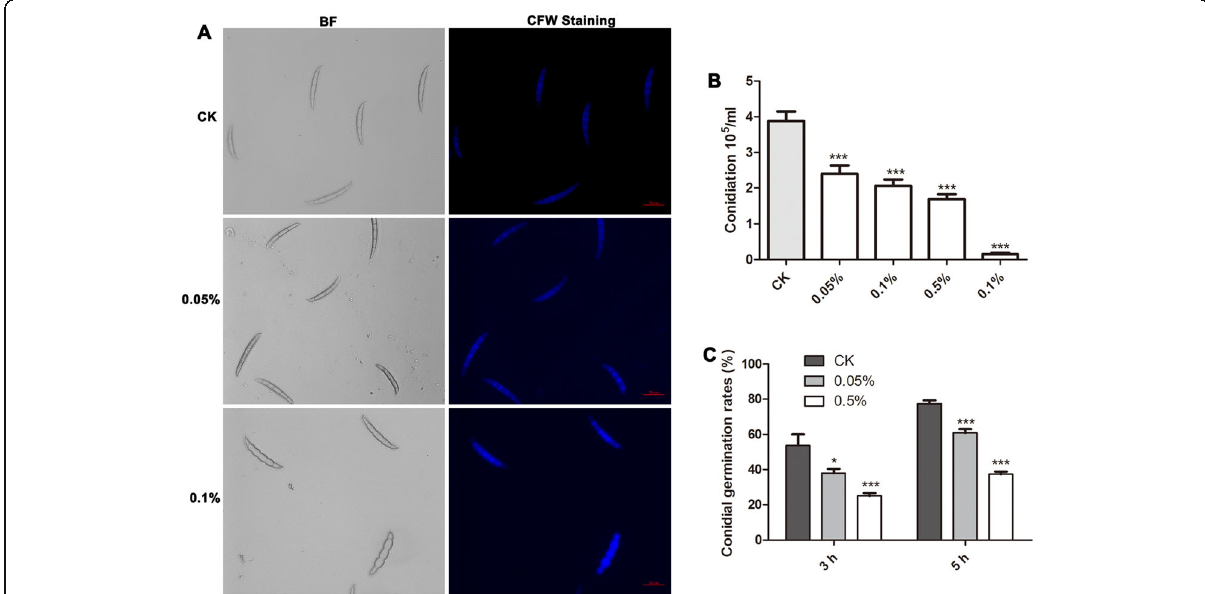
Fig. 2 MG treatment altered conidial morphology, formation and germination. A Conidia were then harvested and examined under fluorescence microscope stained by CFW. B Conidial amounts and C conidial germination were compared between control and MG treatment at the concentration indicated in the figures. Each treatment has three replicates, * means p < 0.05 and *** means p < 0.001. Bar = 20 μ